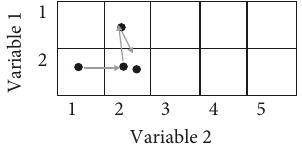
Figure 6: Illustration of four events of a hypothetical variable 1 ( y ) and variable 2 ( x ) in a state space